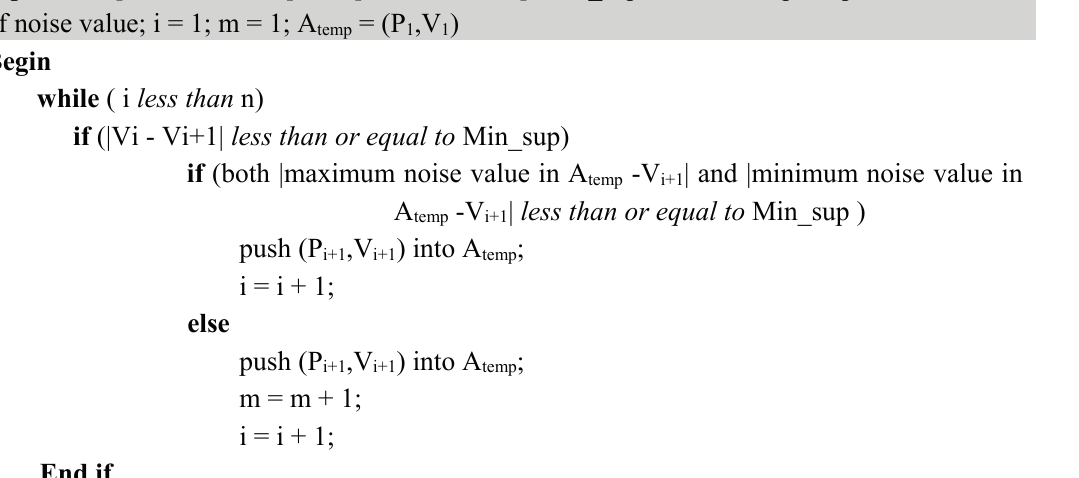
Table 1. The algorithm to determine the set of actual partitions in a road segment. Algorithm 1 to determine a set of actual partitions in a road segment Function